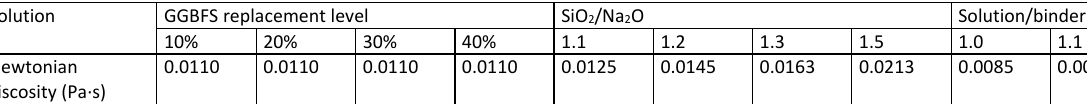
Figure 7. Flow sweep curve for pastes at different solution/binder ratio. Table 4. The viscosity of the activator solutions used in AAM